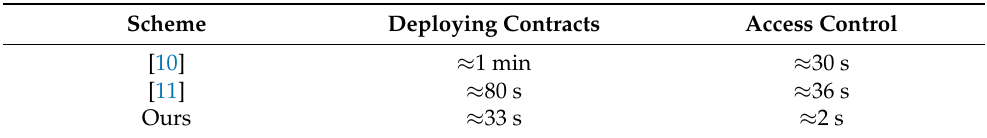
Table 5. Comparison of communication delay for main